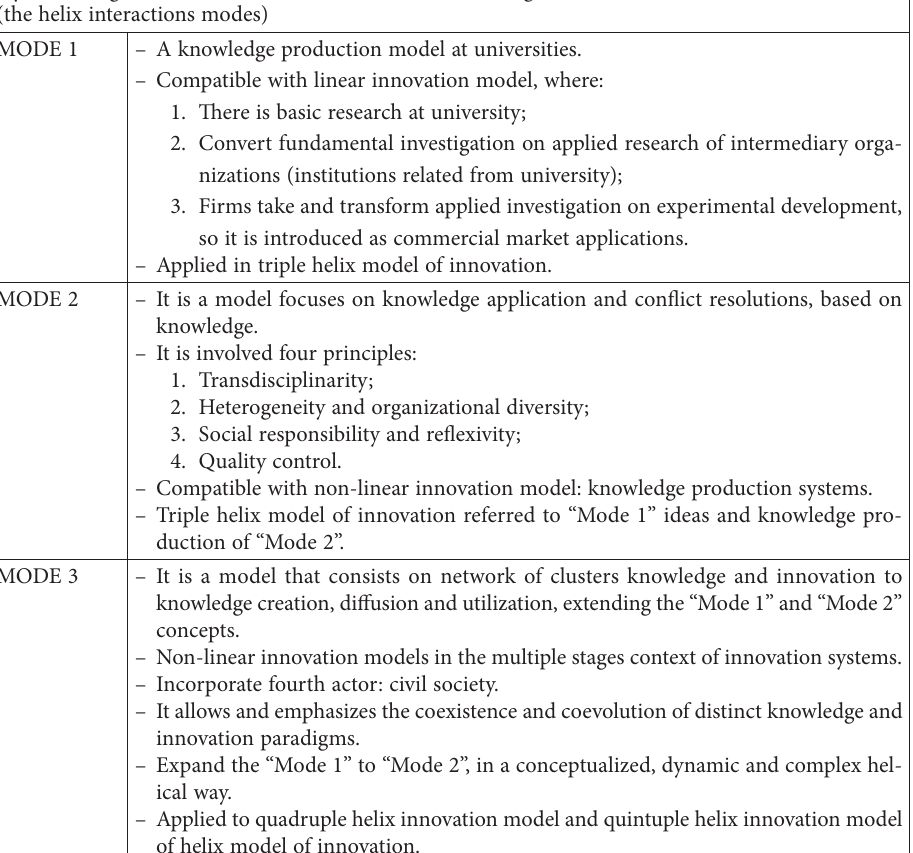
Table 1. Chart 1: dynamic of helix interaction (source: created by authors with a base on Etzkowitz & Leydesdorff (2000), Carayannis & Campbell (2009, 2010), Carayannis et al. (2018)) Dynamic of generation, creation and diffusion of knowledge on helix model of innovation (the helix interactions modes) MODE